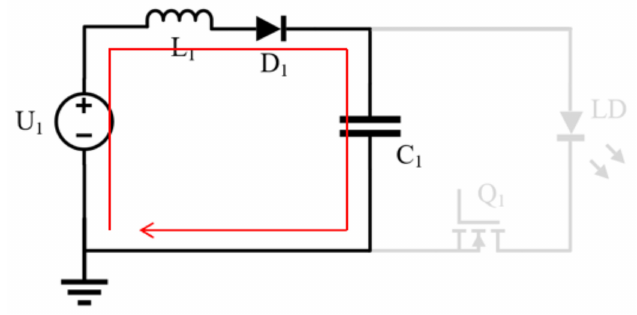
Figure 4. Current path during charging stage.